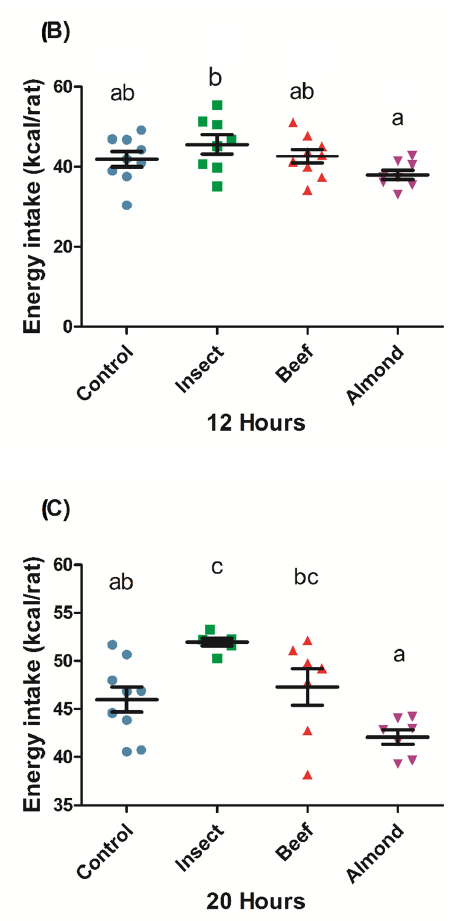
Figure 4. Energy intake after oral administration of a protein dose (300 mg/kg BW). Orally digested samples from insect, beef, or almond were administered to rats. Food intake was measured at three di ff erent intervals: 3 h ( A ), 12 h ( B ), and 20 h ( C ) after the beginning of the dark cycle. The control was an equivalent volume of tap water. The sample size was n = 10 rats per group. The results are expressed as the mean ± SEM. One-way ANOVA and Tukey’s post-hoc test were used for multiple comparisons. Di ff erent letters (a,b,c) indicate significant di ff erences ( p -values < 0.05).The circle, square, and triangle means feeding with di ff erent source of